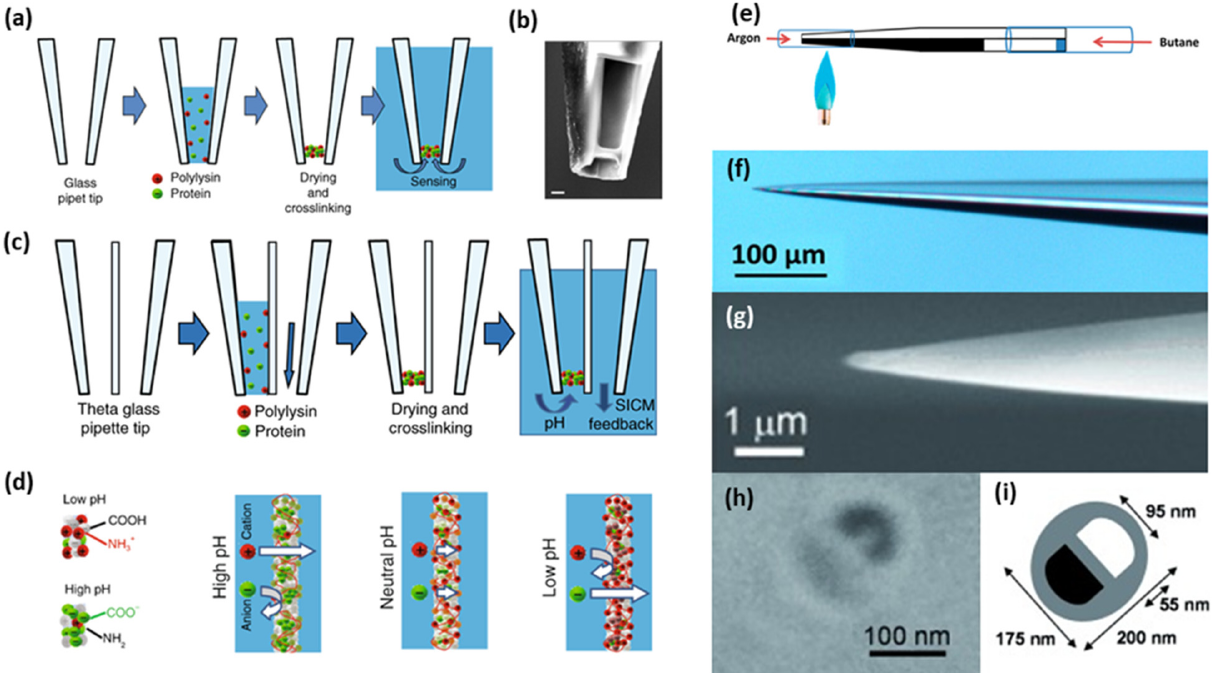
Figure 4. Fabrication and modification steps for both single- and double-barrel pH sensing probes. ( a ) Self-assembly of poly-l-lysine and glucose oxidase (PLL/GOx). ( b ) SEM image after FIB milling (scale bar = 500 nm), showing the thin membrane deposited at the end of the pipette’s tip. ( c ) Self-assembly of PLL/GOx for a double-barrel pH sensor. ( d ) The proposed mechanism for pH sensing using the PLL/GOx nanomembrane. ( e ) Schematic of the procedure for pyrolytic deposition of butane gas into carbon on the inside of one of the double-barrel pipette openings. ( f ) Side view optical image. ( g ) Side view SEM micrograph. ( h ) Bottom view SEM micrograph. ( i ) Schematic of the carbon-based pH sensor before deposition of iridium oxide. Images ( a – d ) were reprinted from ref. [2] under CC-BY 4.0 license. Images ( e , f ) were adapted from ref. [50]. Copyright (2013) with permission from the American Chemical Society. Images ( g – i ) were adapted from ref. [51]. Copyright (2011) with permission from John Wiley and